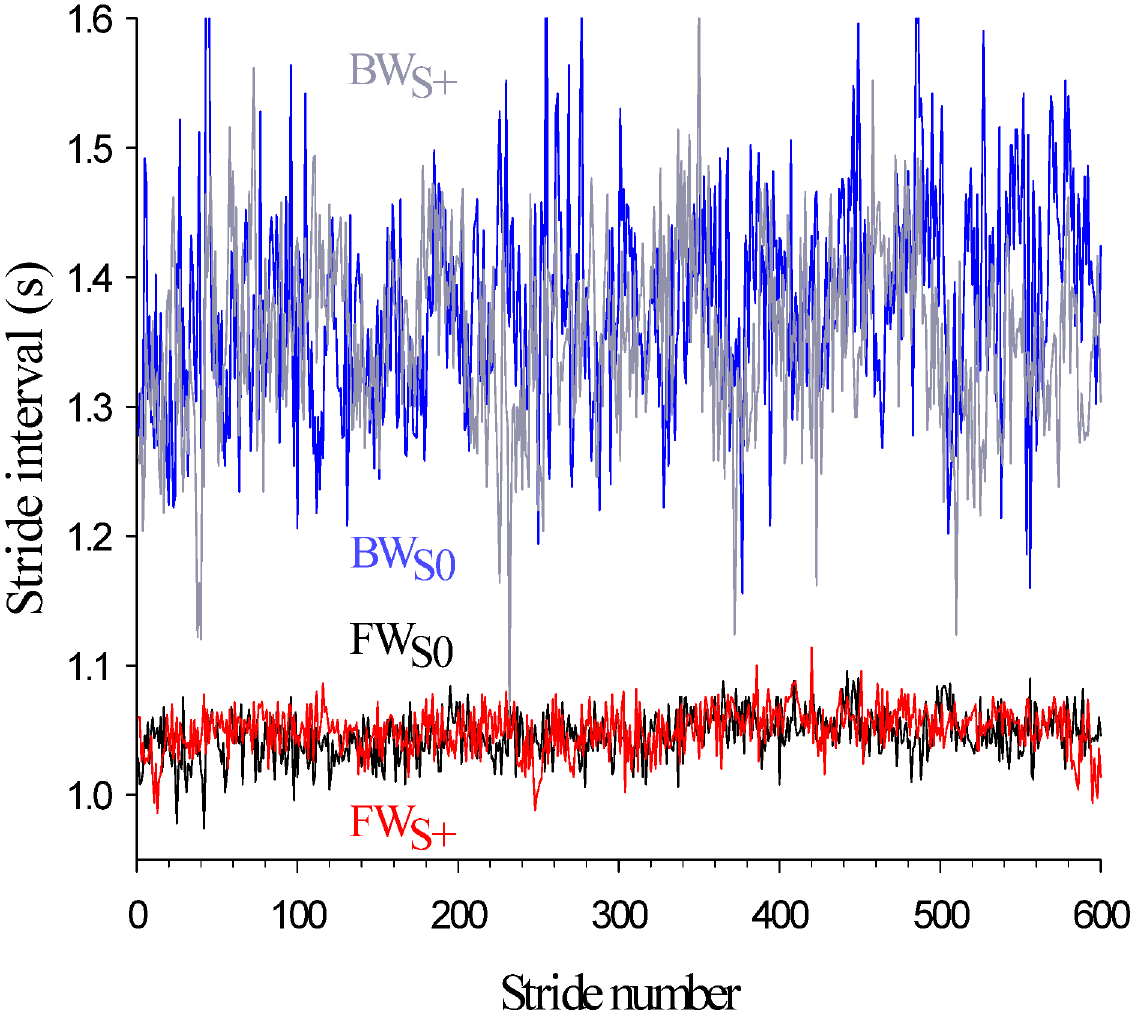
Fig 1. Typical stride interval time series in the different experimental conditions. FW or BW stand for forward and backward walkingrespectively.The indices S + or S 0 indicatethe presenceor absenceof GVS.